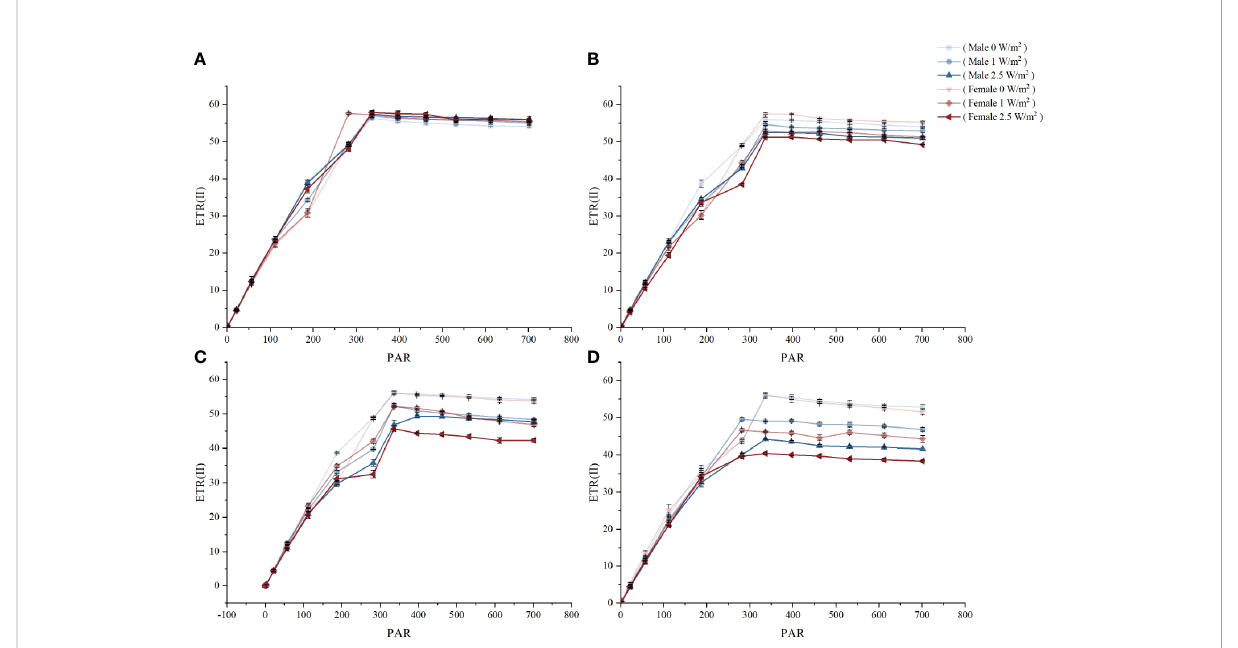
FIGURE 3 The effects on RLC of different treatments in male and female S. thunbergii . (A) day 0; (B) day 1; (C) day 3; (D) day